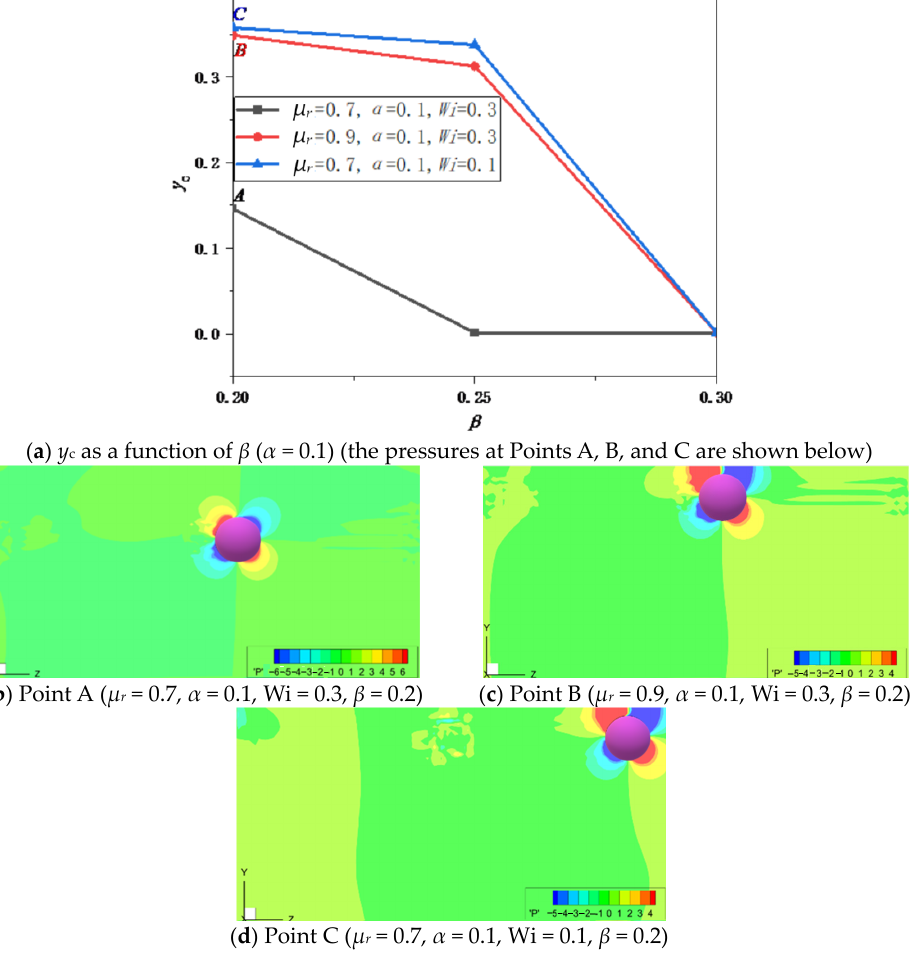
Figure 10. Variation of y c and pressure contours.